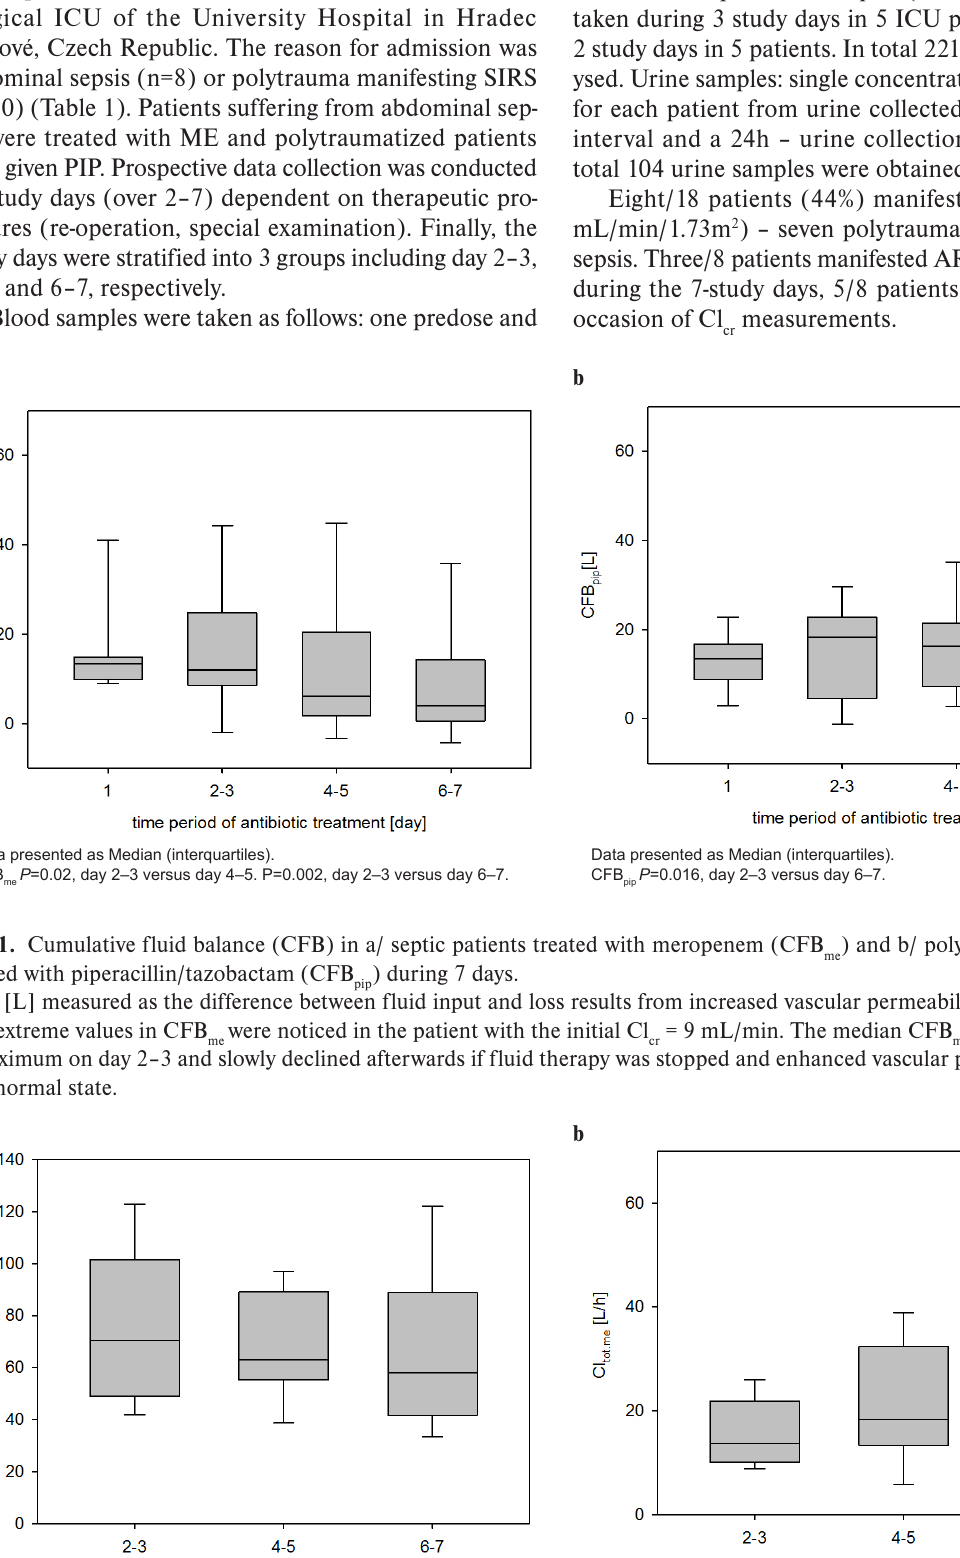
Fig. 2. Meropenem a/ volume of distribution (Vd meropenem at extended infusion dosing 2 g over 3 h every 8 h for 7 days